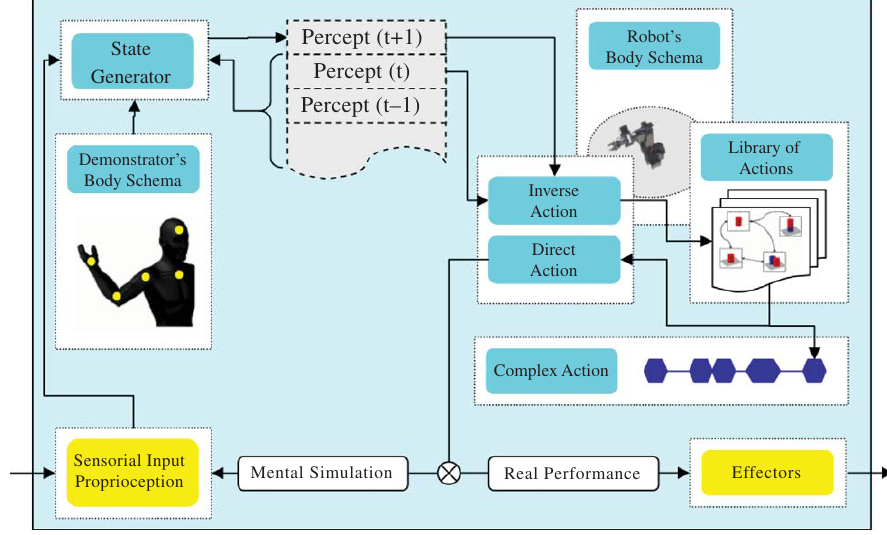
Fig. 3. The interaction of the body percept and the body schema, when the robot system is learning. the output from an action can be inhibited to the effectors, which will produce a mental rehearsal of the action. demonstrator’s actions upon the environment. This is because the system is simulating the states of the demonstrator in order to identify the actions. When a